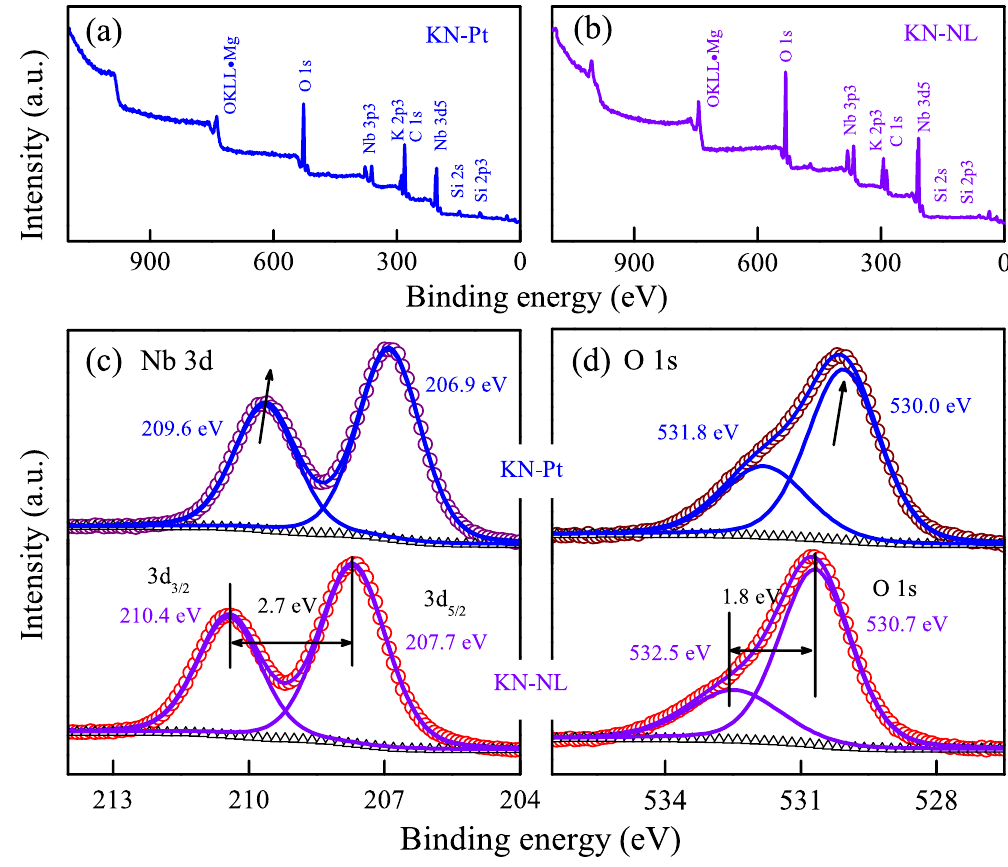
Figure 3. The typical overall XPS spectrum of ( a ) KN-Pt and ( b ) KN-NL. High-resolution XPS spectra of ( c ) Nb 3d and ( d ) O 1 s for KN-Pt and